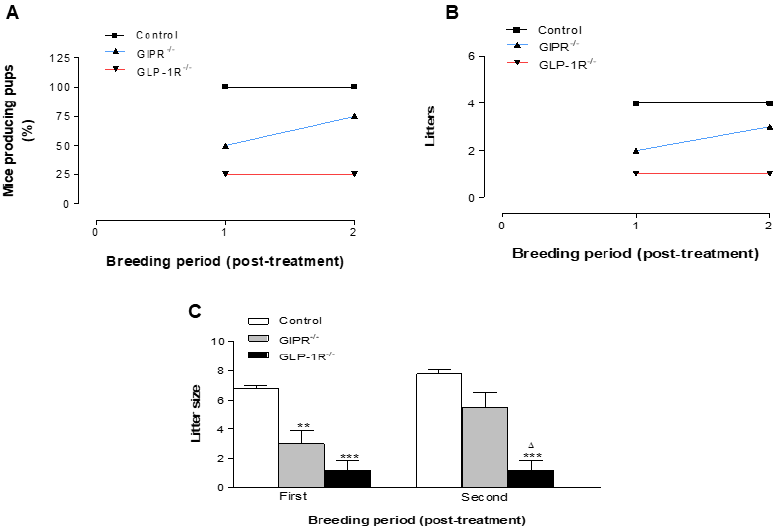
Figure 5. Percentage of animals producing pups, litters and litter size in WT, GIPR − / − and GLP-1R − / − mice treated with metformin. Female (normal, GIPR − / − or GLP-1R − / − ) mice were bred with age-matched normal male C57BL/6 mice over two breeding periods of 20 days each. All animals were treated with metformin (300 mg/kg body weight) dissolved in drinking water throughout the period of the experiment. ( A ) Percentage of mice producing pups, ( B ) litters produced and ( C ) average litter size in female WT, GIPR − / − and GLP-1R − / − mice post metformin treatment. Litter size corresponds to number of pups in each litter whilst litter refers to number of litters produced. Values are mean ± SEM with n = 4. ** p < 0.01, *** p <0.001 compared to control. ∆ p < 0.05 compared to GIPR − / −